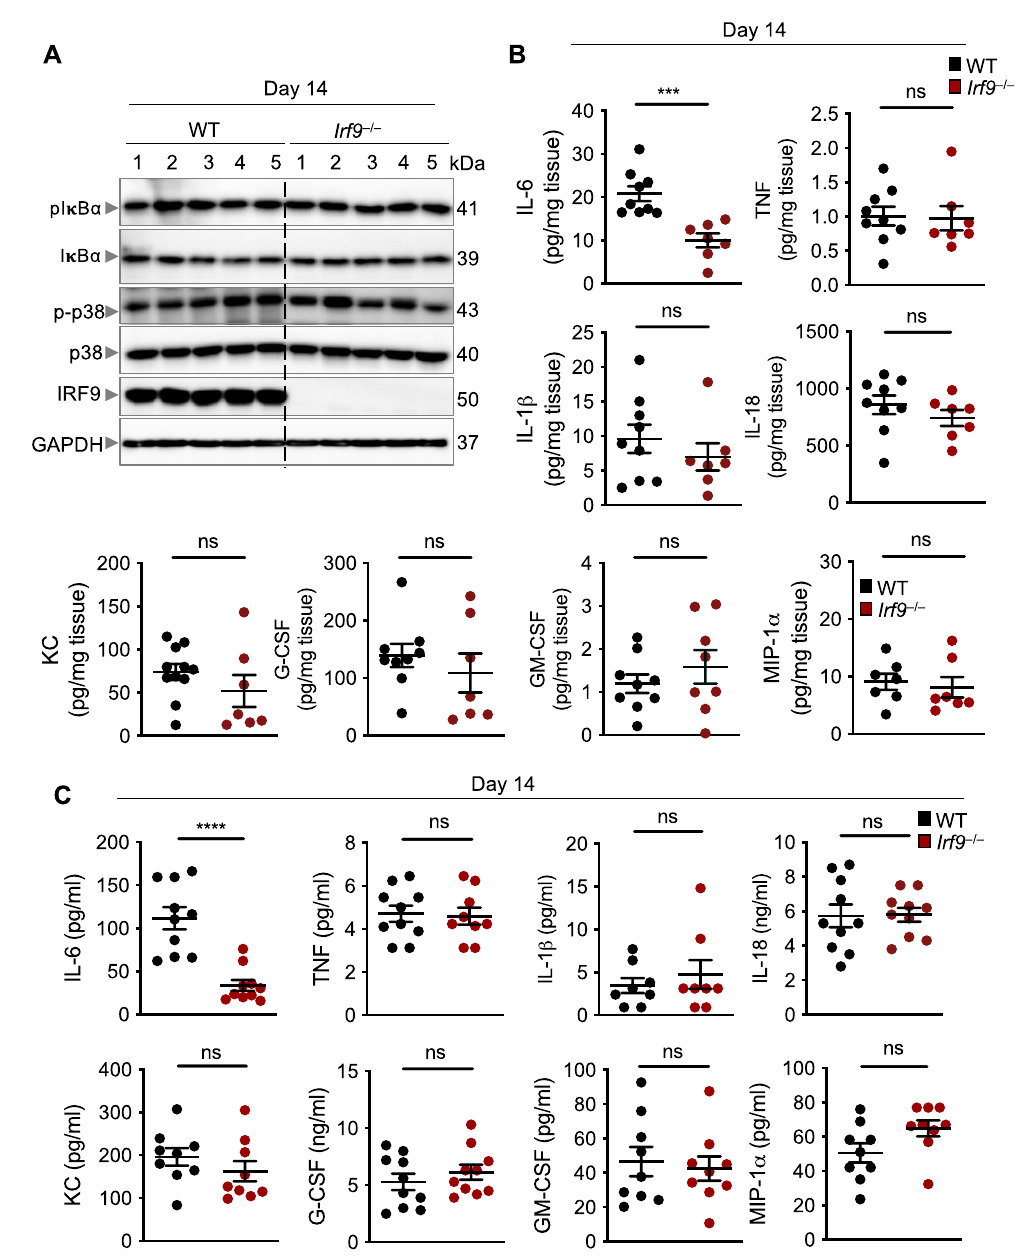
Figure 3. IRF9 does not regulate inflammatory signaling but does regulate IL-6 production in the colon. ( A ) Immunoblot analysis of phosphorylated and total IκBα (pIκBα and IκBα, respectively), phosphorylated and total p38 (p-p38 and p38, respectively), IRF9, and GAPDH (loading control) in colon lysates from wild type (WT) and Irf9 –/– mice. Each lane corresponds to an individual mouse. ( B ) Levels of inflammatory cytokines in the colon of WT (n = 7–9) and Irf9 –/– (n = 7–8) mice 14 days after AOM injection. ( C ) Levels of inflammatory cytokines in the serum of WT (n = 8–10) and Irf9 –/– (n = 8–10) mice 14 days after AOM injection. Each symbol represents an individual mouse in B and C. ns, not statistically significant. *** p < 0.001, **** p < 0.0001. Two-tailed t -test was used in B and C. Data are represented as mean ± SEM in B and C.